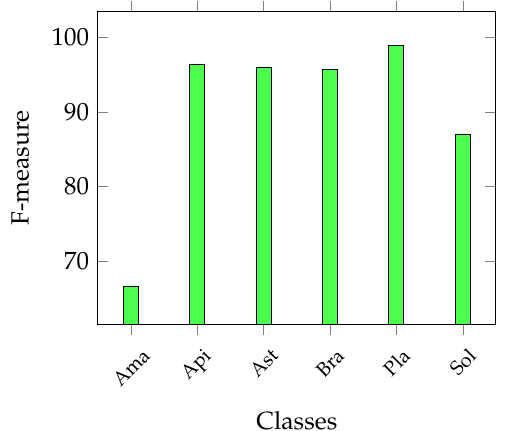
Figure 7. Classwise MFM on the best model for the Canada data set trained with deep features: SVM with ResNet50 features.